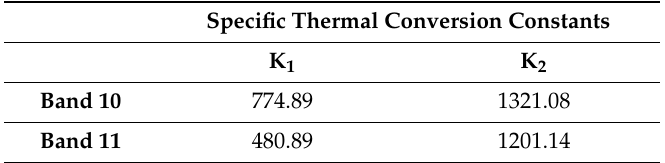
Table 2. Specific thermal conversion constants for bands 10 and 11 of Landsat 8.